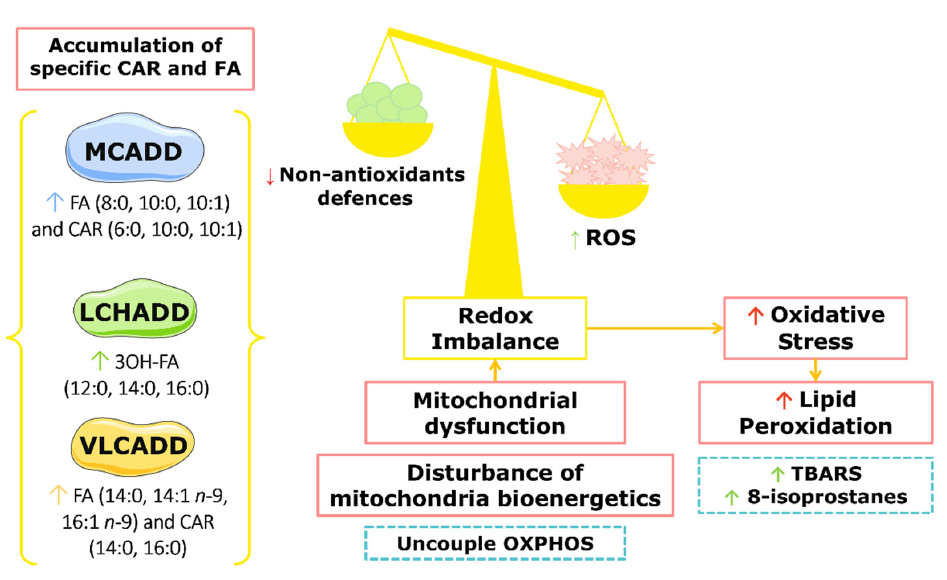
Figure 2. Schematic representation of the effects of specific FA and CAR accumulation in the patho- genesis of FAODs, its correlation with oxidative damage, and consequent disturbance of mitochon- drial homeostasis.